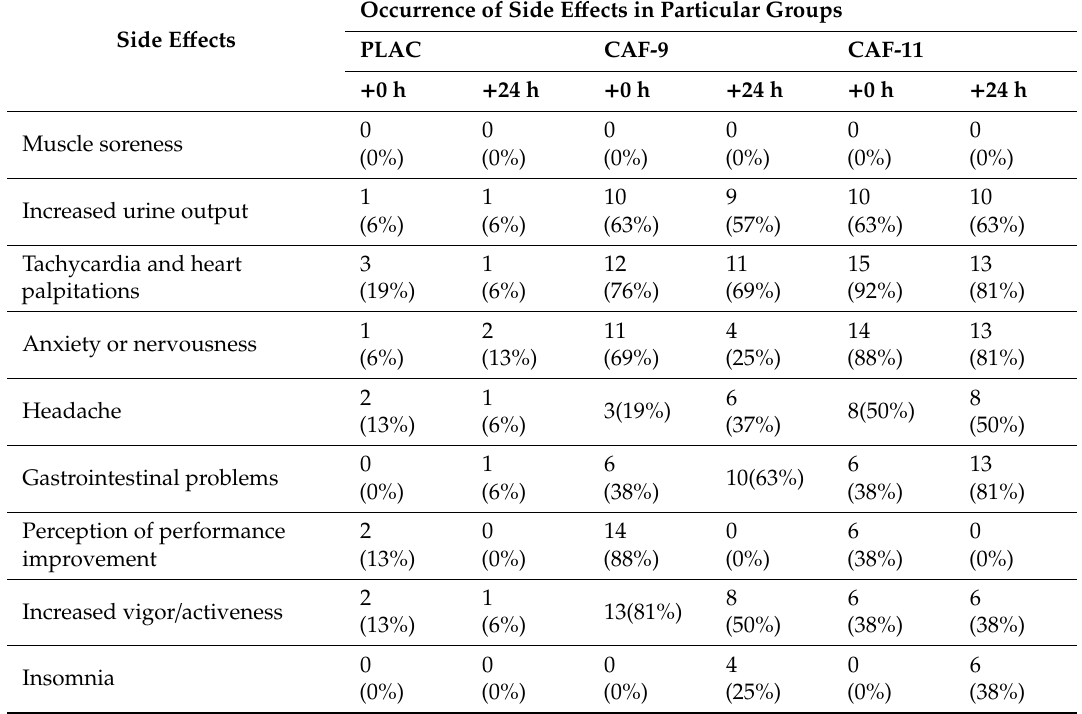
Table 3. Number (frequency) of participants that reported side e ff ects immediately after the testing protocol (side e ff ects questionnaire (QUEST) + 0 hour) and 24 hours later (QUEST + 24